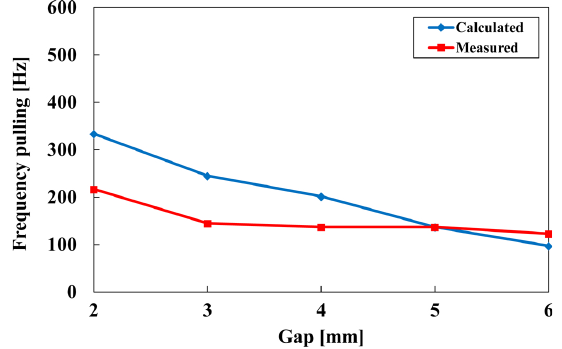
Figure 20. Calculated and measured angular frequency pulling at di ff erent gaps.